Question: Condense the content of this figure into a single sentence.
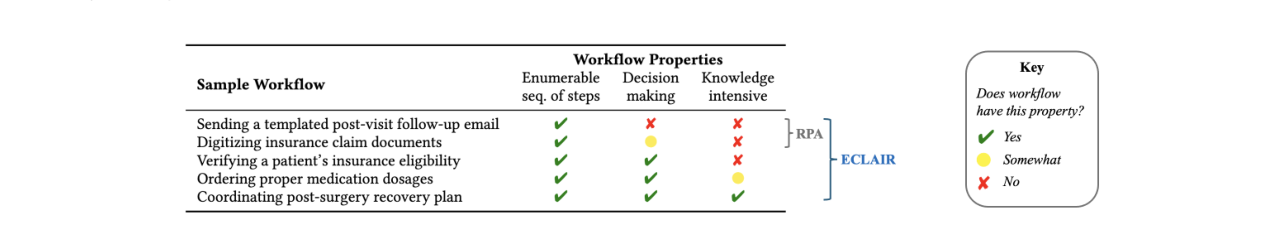
Answer: ECLAIR can automate entirely new categories of workflows, such as those that contain hard-to-describe steps, require complex decision making, or are knowledge intensive. Listed examples are real-world hospital workflows (see Section 3.1).